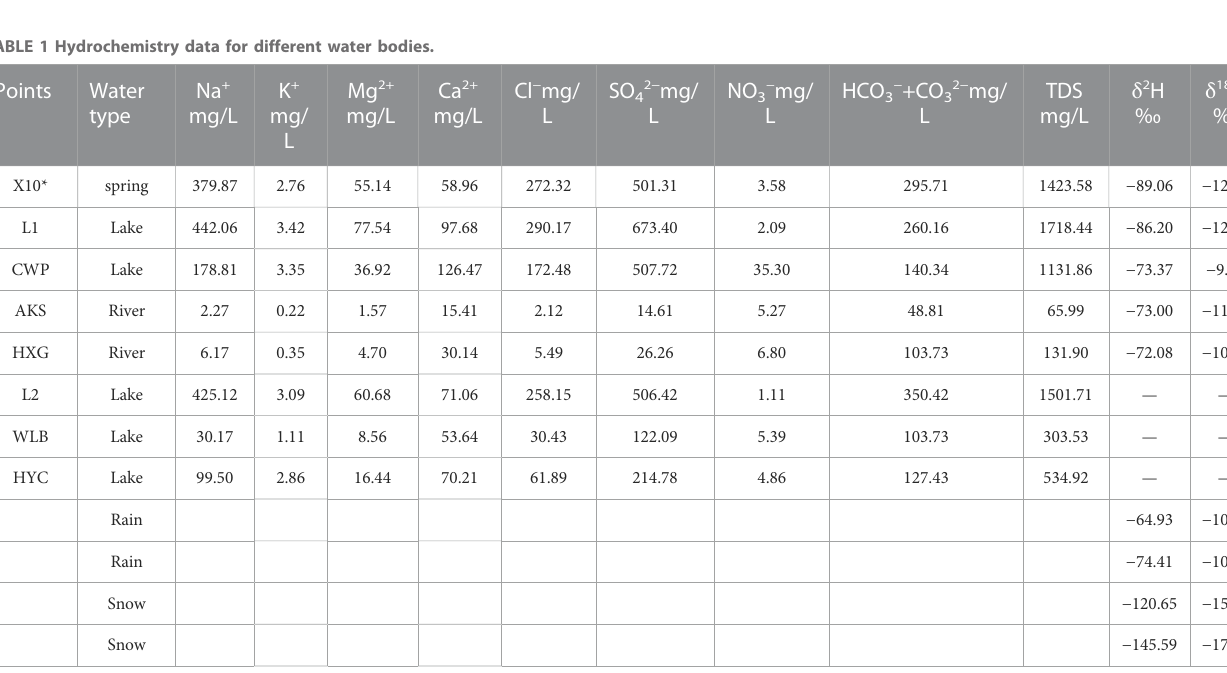
30-mL polyethylene bottles, respectively. Each sample was stored full in cleaned polyethylene bottles and fi ltered through a 0.45 μ m membrane before measured. All water samples were examined in the Laboratory of Crustal Dynamics, China Earthquake Administration. Concentrations of HCO 3 − and CO 3 2 − ions were determined using the traditional titration with HCl. Na + , K + , Ca 2+ , Mg 2+ , SO 4 2 − , NO 3 − and Cl − concentrations were measured using ICS- 2100 ion chromatography. The reliability of chemical data was